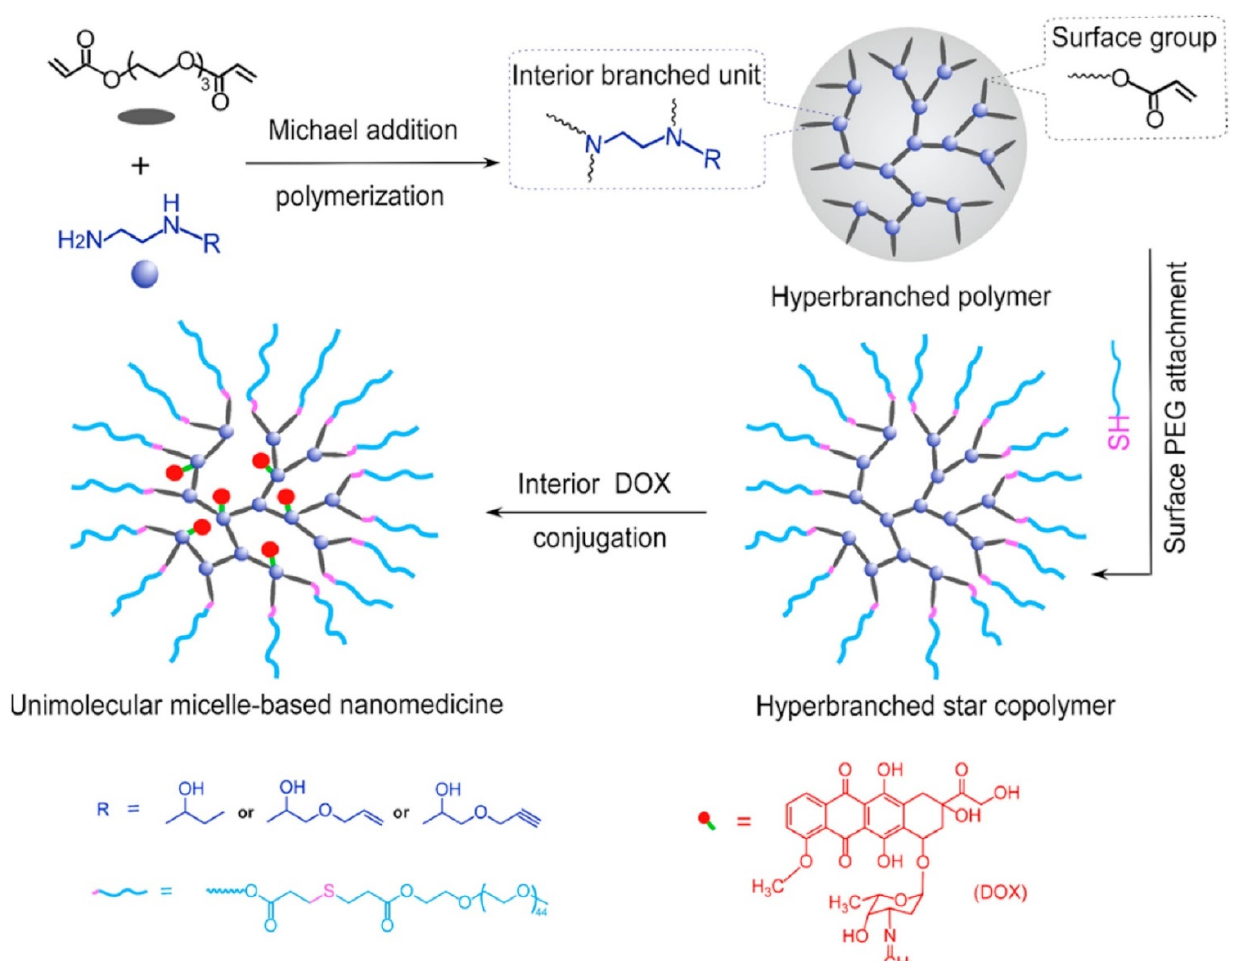
Figure 9. The synthesis of unimolecular micelle-based nanomedicines as described by Liang et al. Reprinted with permission from [75]; published by Elsevier, 2020.